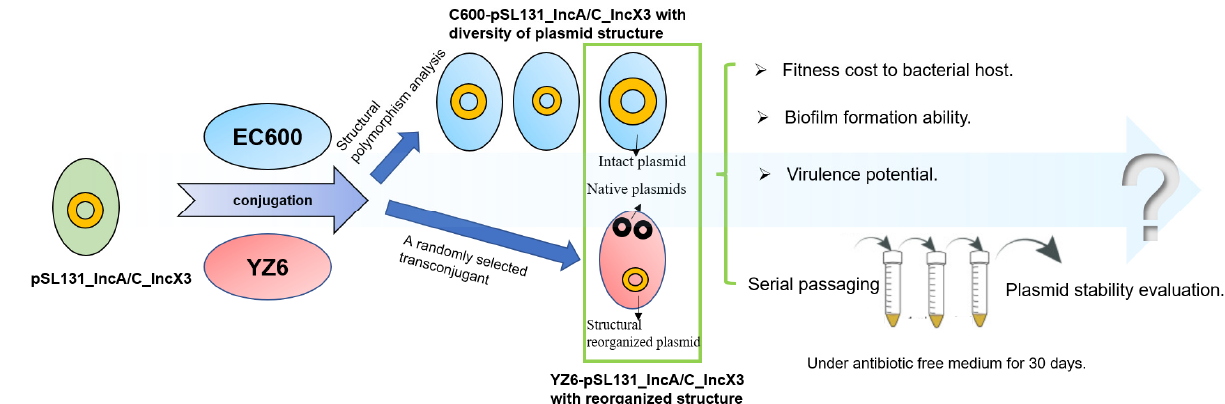
Figure 1. Schematic diagram of research process. A cointegrate plasmid (pSL131_IncA/C_IncX3) was transferred by conjugation into Escherichia coli EC600 and Klebsiella pneumoniae YZ6. Analysis of structural polymorphism was conducted after plasmid acquired by EC600. EC600 carrying intact plasmid and YZ6 carrying structural reorganized plasmid were subjected to fitness evaluation and serial passaging under antibiotic-free conditions for 30 days. Yellow circles in different sizes represented changes in cointegrate plasmid size during conjugation.